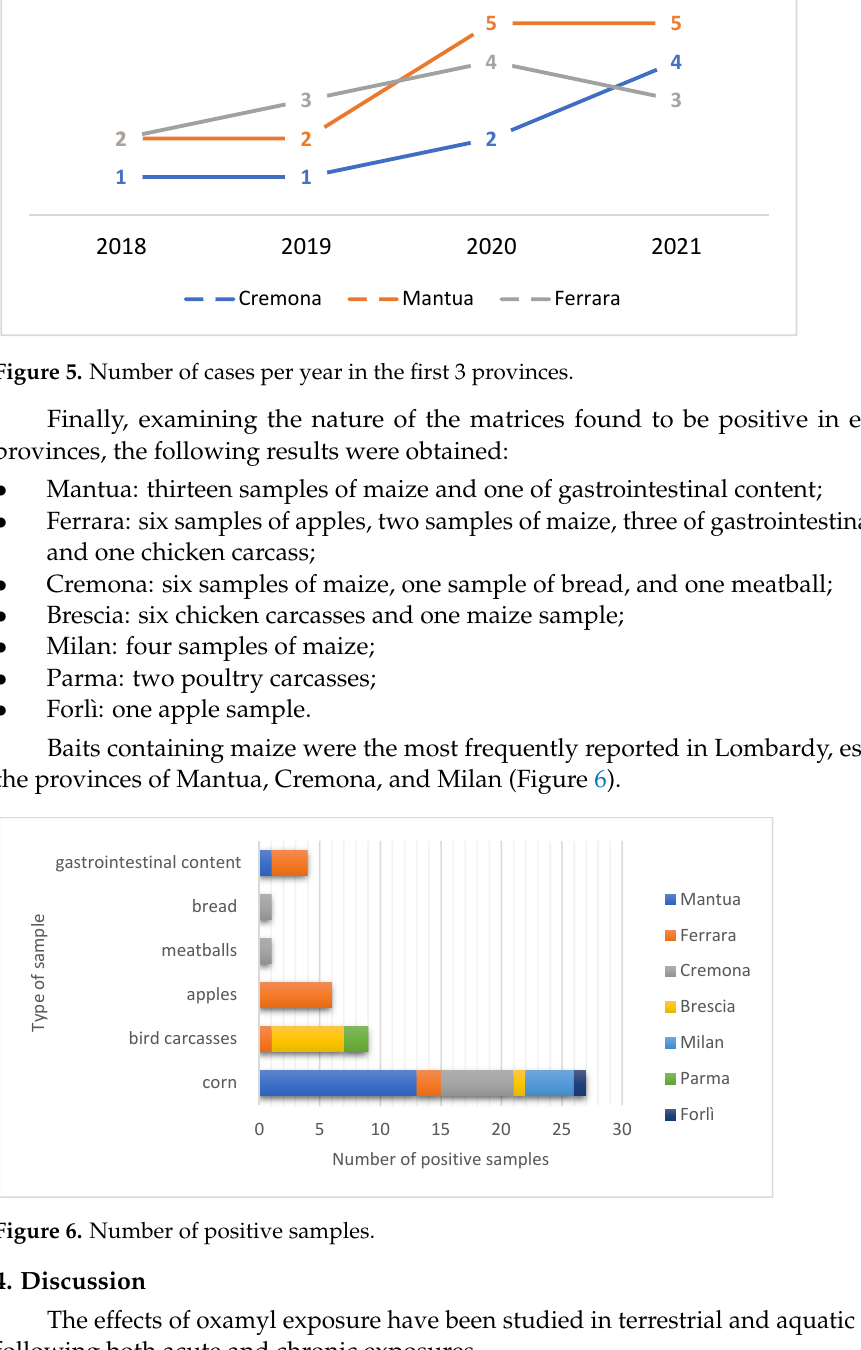
Figure 4. Number of positives, in percentage values, for each province.